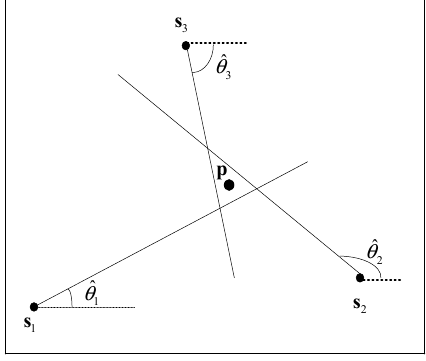
Figure 1. Illustration of angle of arrival (AOA) localization with three nodes deployed in the test area.